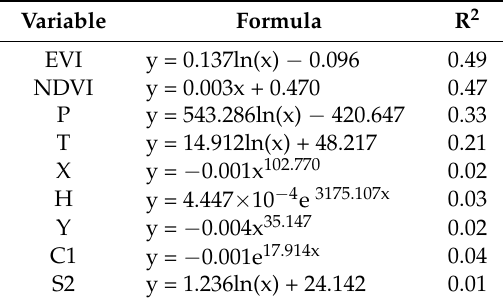
Table 5. Best fitted models constructed based on a single factor.